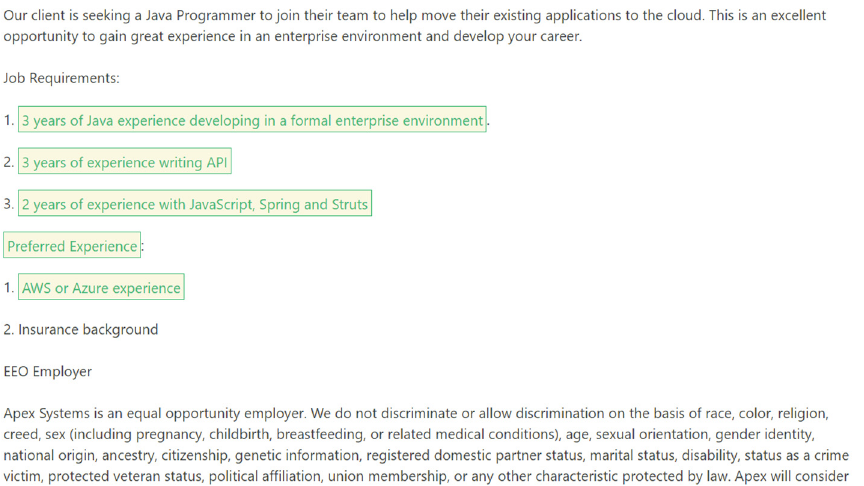
Figure 8. Processed job advertisement containing green-marked sentences with job requirements.